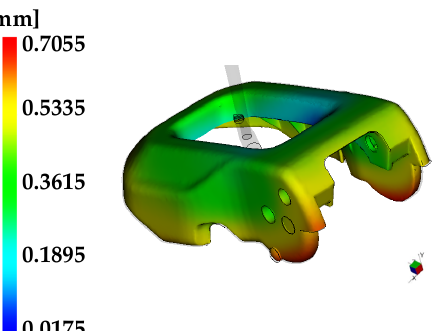
Figure 16. Deflection of the open lever with 0.5% shrinkage-rate constant applied and additional correction of dimension 2. Table 25. Measurement results of dimension 1, 2, and 3 of the open lever with shrinkage-rate con- stant applied and additional correction of the dimension 2.